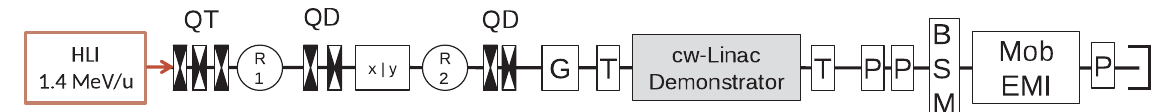
FIG. 5. Layout of matching line to the demonstrator and beam diagnostics test bench; QT ¼ quadrupole triplet, QD ¼ quadrupole duplet, R ¼ rebuncher, X/Y ¼ beam steerer, G ¼ SEM-grid, T ¼ beam current transformer, P ¼ phase probe, BSM ¼ bunch shape monitor, EMI ¼ emittance